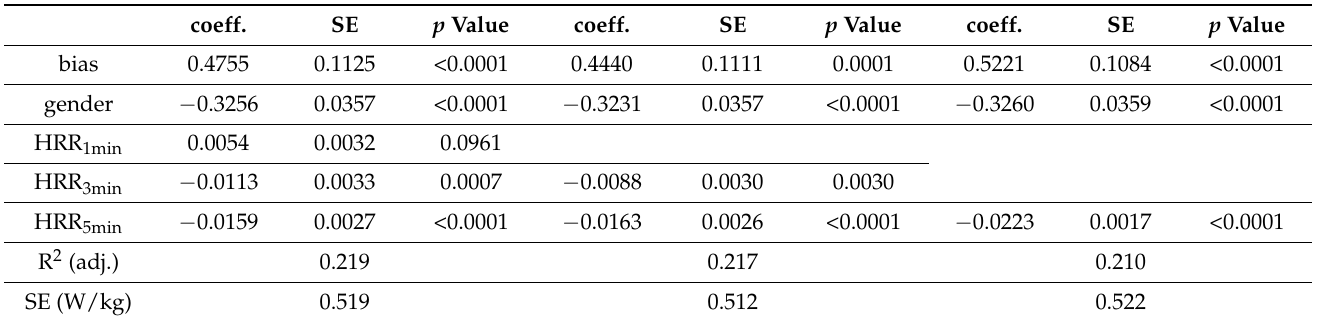
Table 2. Multiple linear regressions of weight-related performance at IAT in W/kg using gender (m = 0, f = 1) and HRR values after 1, 3, and 5 min.